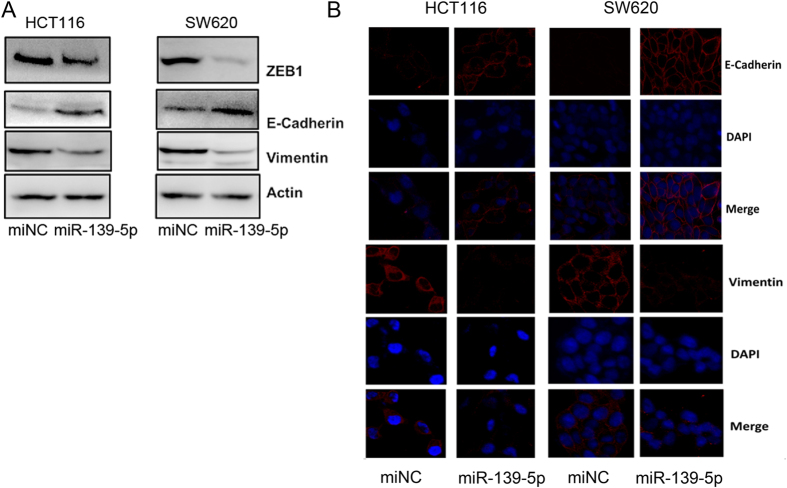
miR-139-5p inhibits the epithelial-mesenchymal transition in colon cancer.(A) Western blot analysis of the phenotypic markers, including E-cadherin, Vimentin, and ZEB1 in miR-139-5p overexpression cells. β-Actin expression was used as the loading control. (B) Confocal microscopy analysis of the phenotypic markers, including E-cadherin and Vimentin. The red signal represents the staining of the corresponding protein, and the blue signal represents the nuclear DNA staining by DAPI.